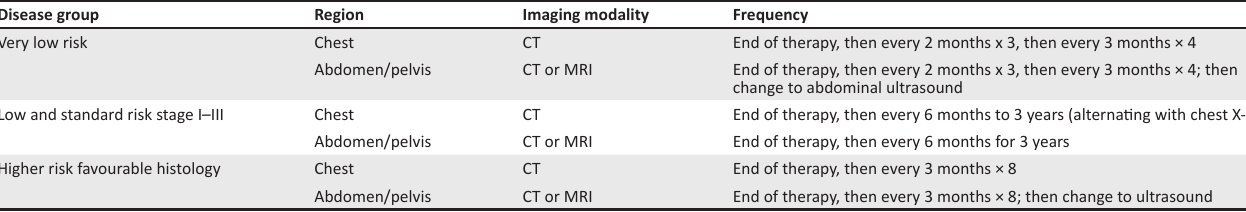
TABLE 1: COG recommendations for CT as part of off-therapy surveillance imaging in Wilms tumour. 5 Disease